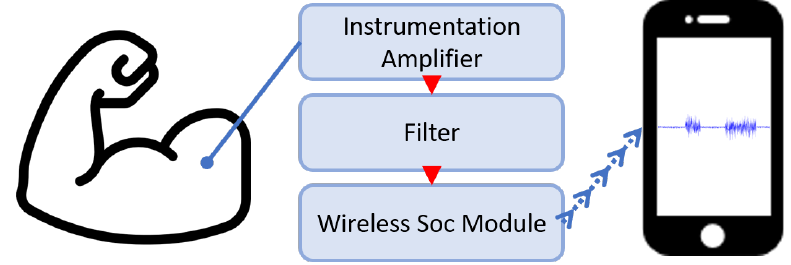
Figure 1. Overview of the proposed surface EMG acquisition system.